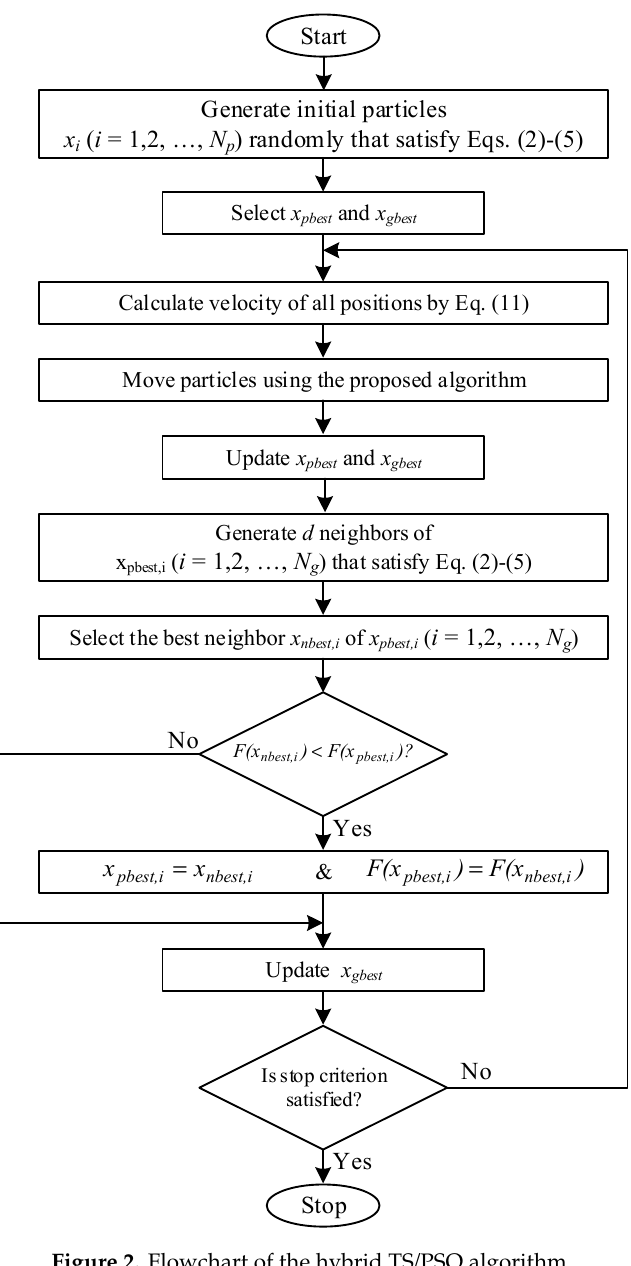
Figure 2. Flowchart of the hybrid TS/PSO algorithm.